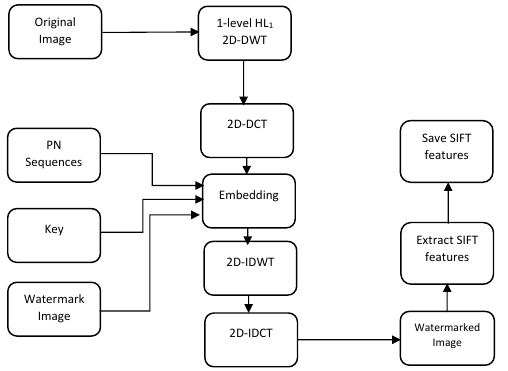
Figure 4. The proposed embedding scheme. The steps of watermark insertion are described in detail in Algorithm